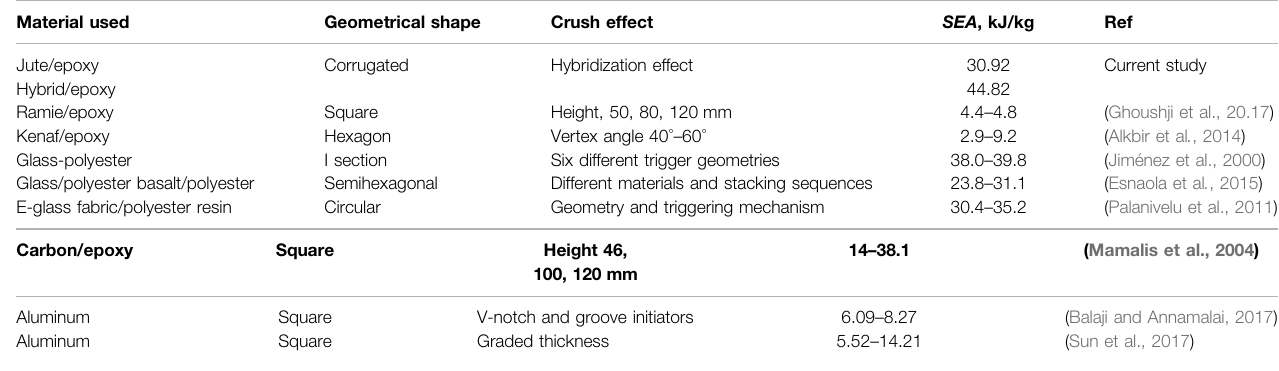
TABLE 3 | Summarized current work and comparing the result with previous reported